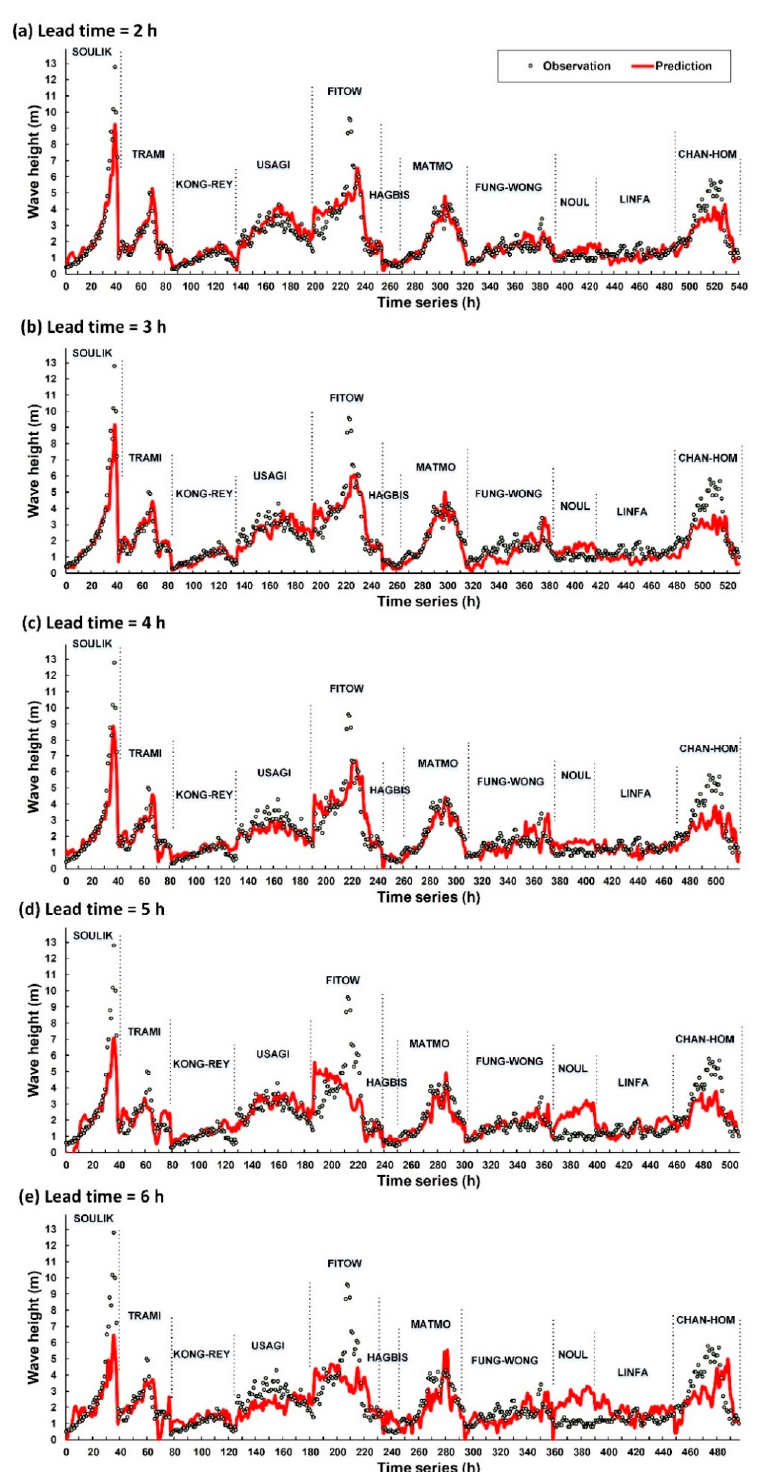
Figure 12. Wave height prediction of lead time = 2 to 6 h at Longdong buoy: ( a ) lead time = 2 h; ( b ) 3 h; ( c ) 4 h; ( d ) 5 h; and ( e ) 6